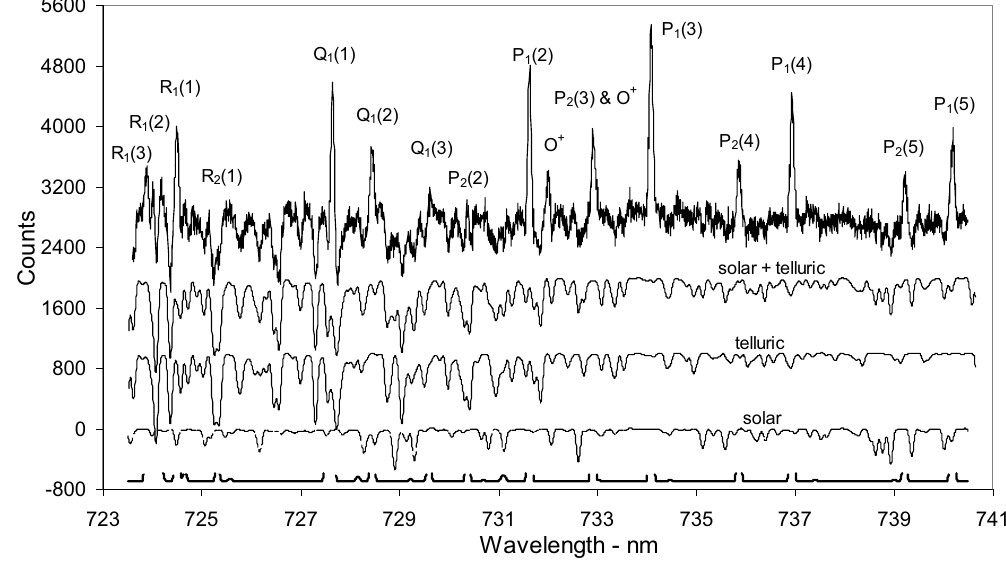
Fig. 3. Scattered moonlight influence (126 summed spectra, scattered moonlight, no aurora apparent). The Kitt Peak solar and telluric spectra, both combined and separately, and a theoretical hydroxyl spectrum are shown below the summed spectrum.